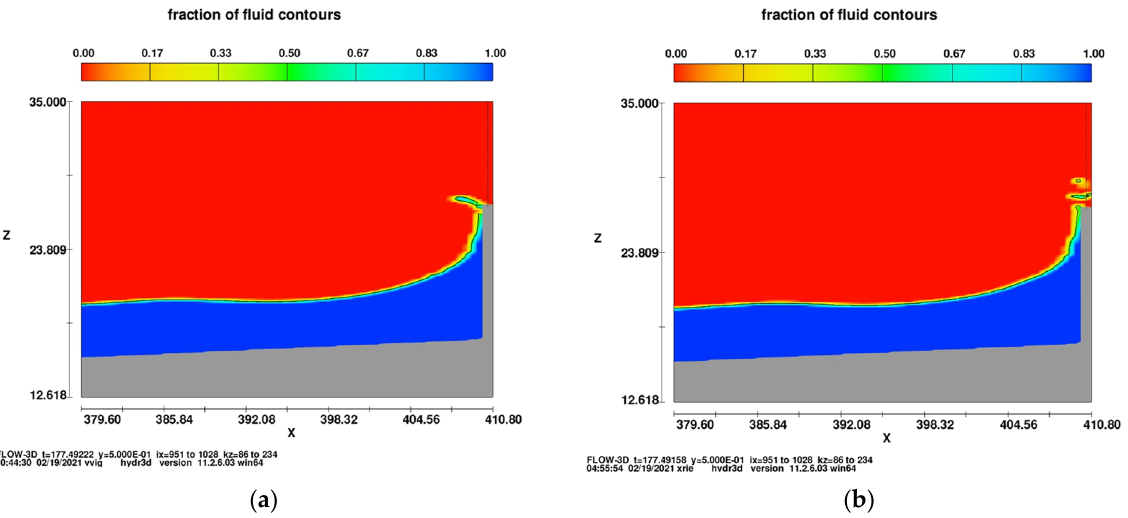
Figure 6. Up-rushing jet on wave overtopping for different simulation at the time 177.5 s, TEST_3 and Rc = +8.50 m. Panel ( a ) no wind; panel ( b ) wind velocity U 10 = 19 m/s.